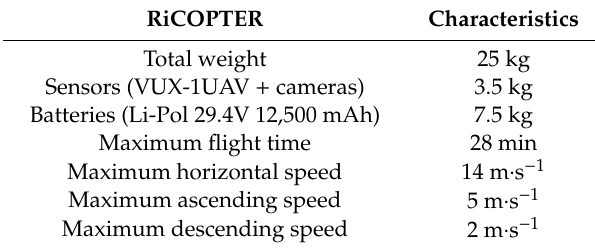
Table 1. Detailed information about VUX-SYS provided by [36].